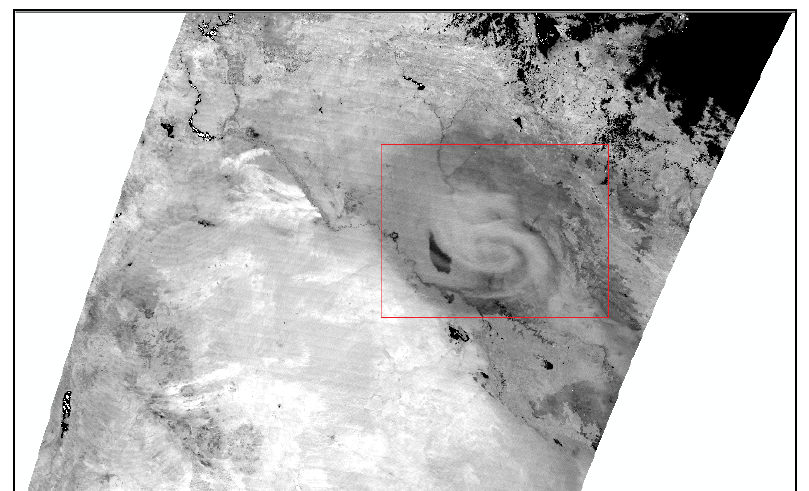
Fig. 4: Applying NDDI index on 1/9/2015 MODIS terra satellite image.